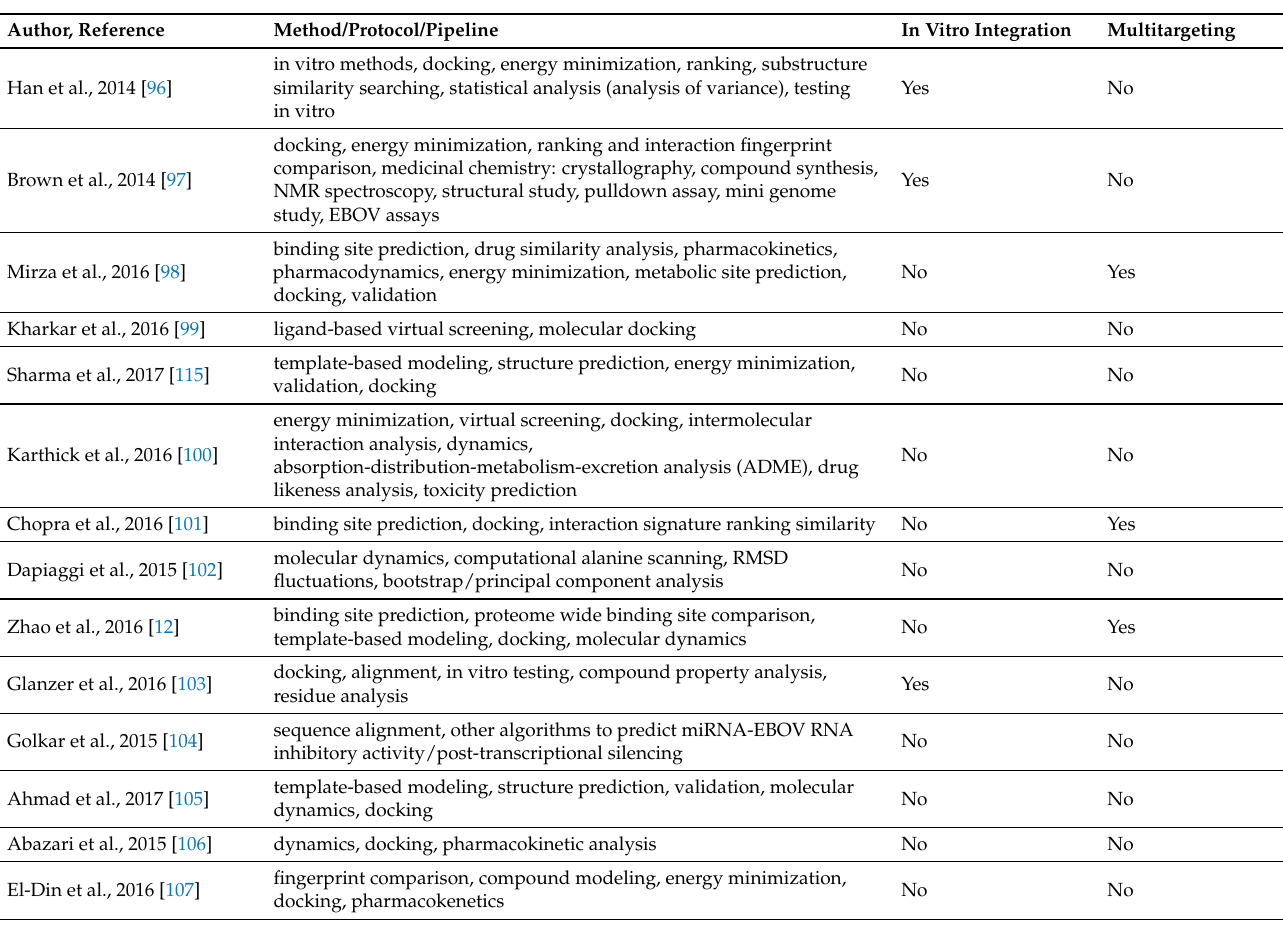
Table 2. Protocols used by the studies reviewed. The general protocol/method/pipeline, and their classification according to whether they include in vitro integration and/or multitargeting, is given for each study. We classify five studies as integrating in vitro methodology (such as assays, X-ray diffraction, or other methodology) and five studies as taking a multitargeting approach. Multitargeting approaches appear to have the best potential to be the most effective in the search for EVD treatment (particularly along with preclinical and clinical